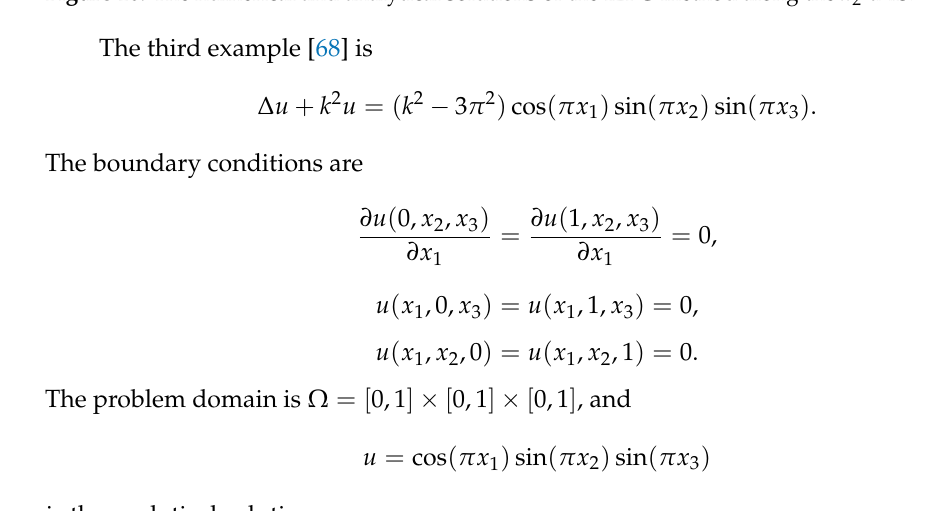
Figure 16. The numerical and analytical solutions of the IEFG method along the x 2 -axis.